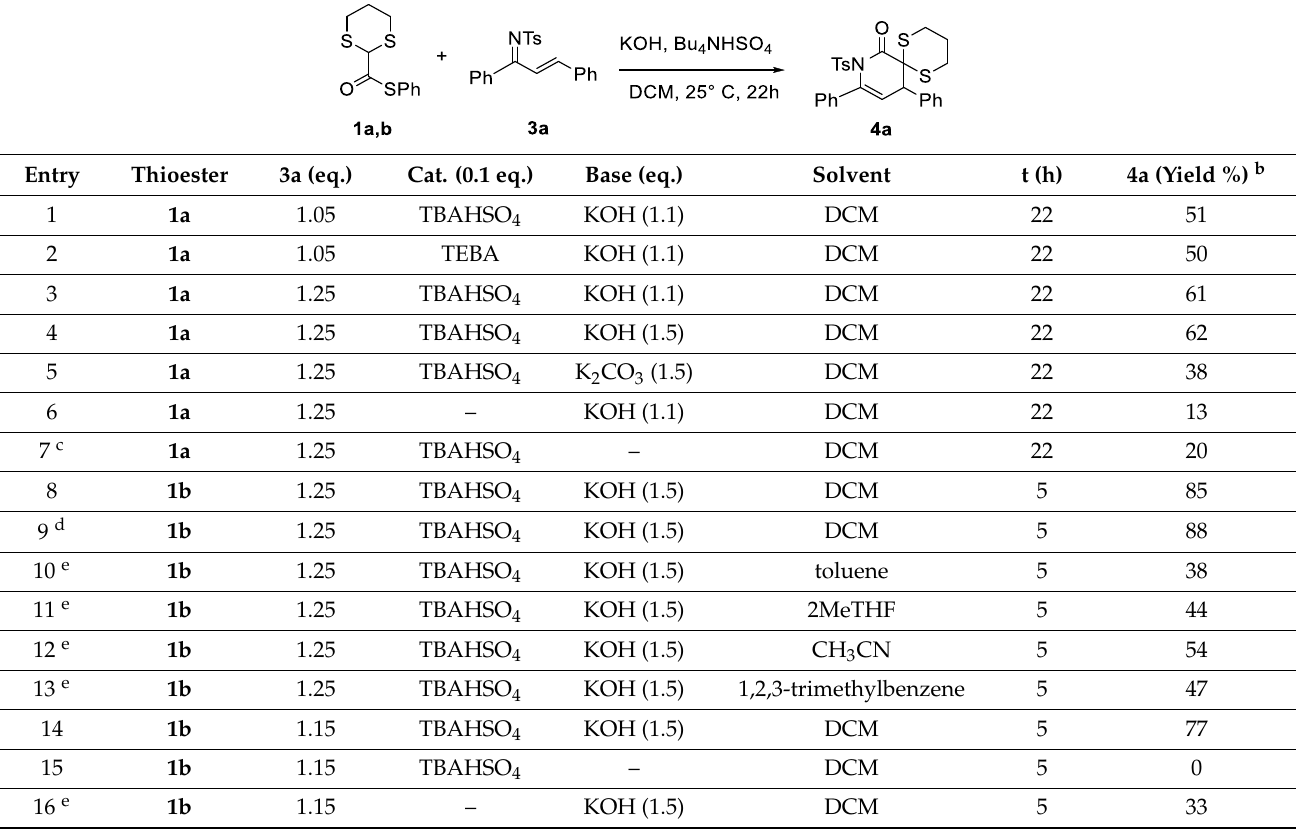
Table 1. Optimization of reaction conditions a .